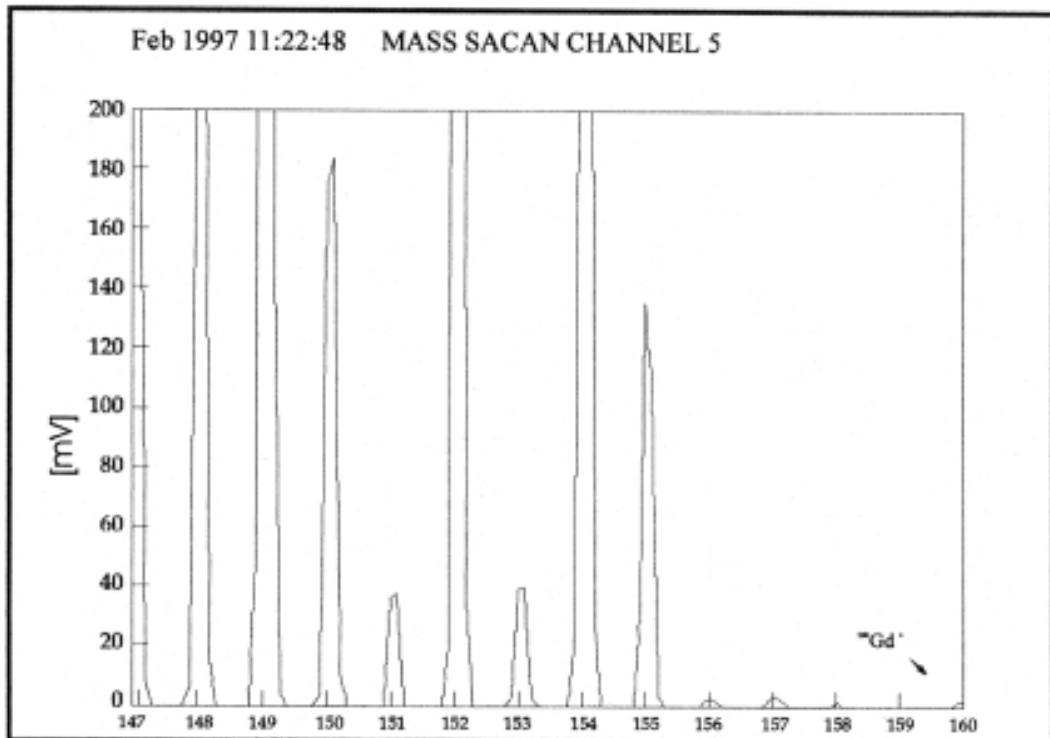
Fig. 6 – Interference of Gd on Sm. Increased scale, with 2.2 volts for 149 Sm.